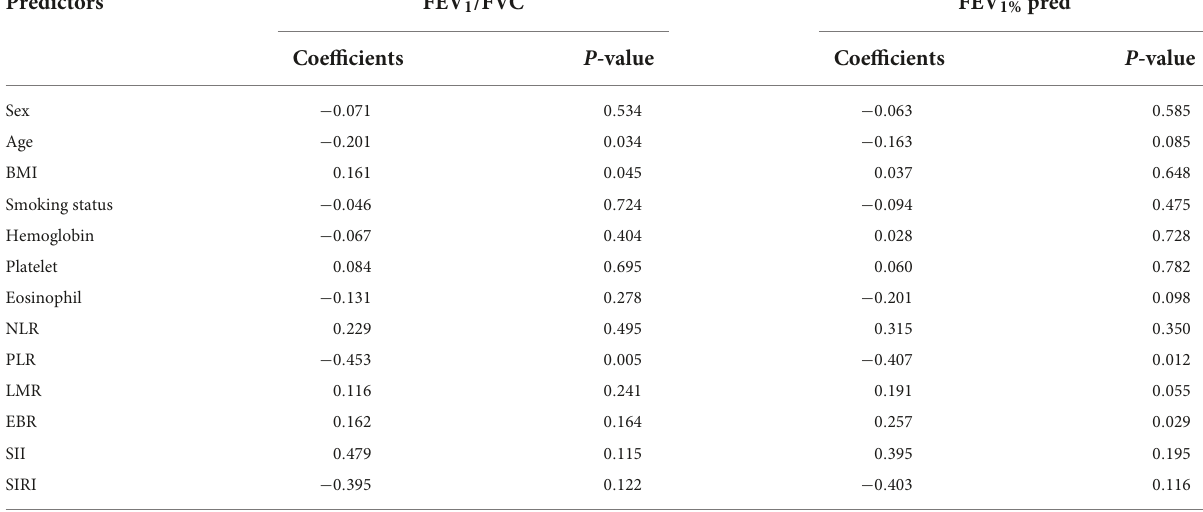
TABLE 5 Multivariate correlation between pulmonary function and inflammatory